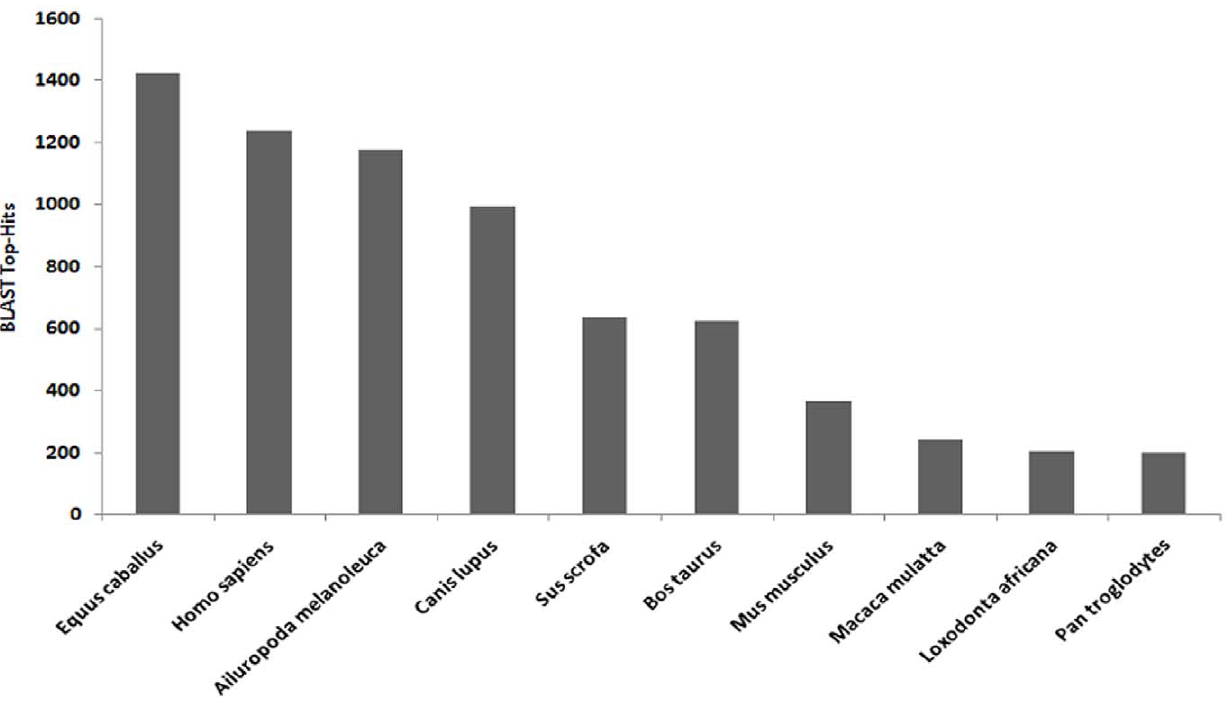
Figure 2. Species with more than 100 top hits from B2G.